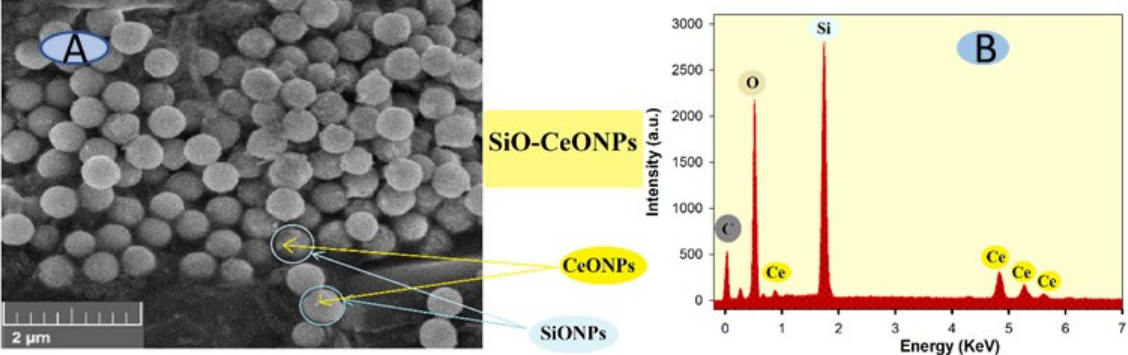
Figure 1. ( A ) Scanning electron morphology (SEM) of the SiO-CeONPs with ( B ) electron dispersive spectroscopy (EDS).